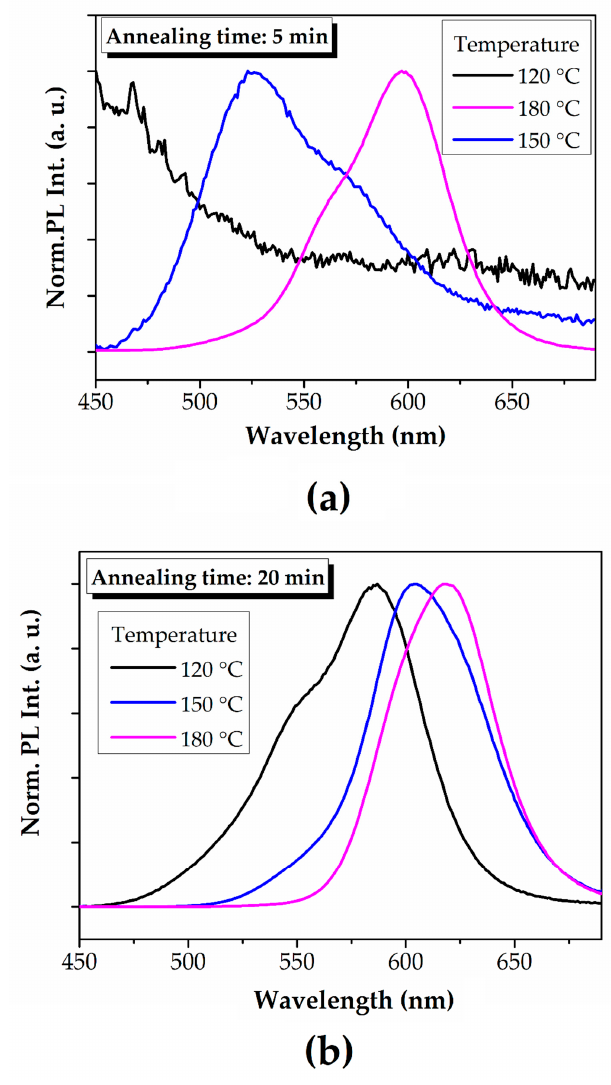
Figure 1. Normalized emission spectra of CdTe QDs synthetized in film at different temperatures: 120 °C (black line), 150 °C (blue line) and 180 °C (purple line): ( a ) at 5 min and ( b ) 20 min. Figure 1b shows the PL emission spectra for three films annealed at different temper- ature (120, 150, and 180 °C) for a longer time of 20 min. As a general trend, one can see